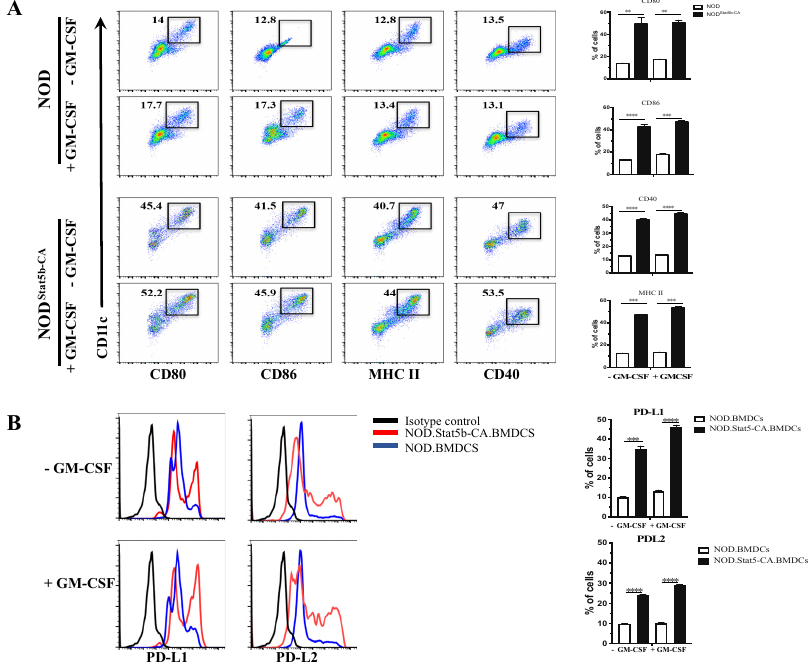
Figure 1. Stat5b-CA.BMDCs display tolerogenic properties. Bone marrow-derived dendritic cells (BMDCs) (1 × 10 5 cells / well) were generated from NOD and NOD.CD11c Stat5b-CA mice and cultured for 48 h in the absence or presence of granulocyte-macrophage colony-stimulating factor (GM-CSF) (50 ng / mL). ( A ) Cell surface expression of CD80, CD86, CD40, and MHC II. Numbers in the windows correspond to the percentages of positive cells with respect to total population of BMDCs. ( B ) Expression of PD-L1 and PD-L2 on CD11c + BMDCs was determined by multicolor flow cytometry analysis in cells exposed or not to GM-CSF. Data are representative of three independent experiments. The asterisks indicate statistically significant di ff erences determined by one-way ANOVa tests. p < 0.01 (**), p < 0.001 (***), and p < 0.0001